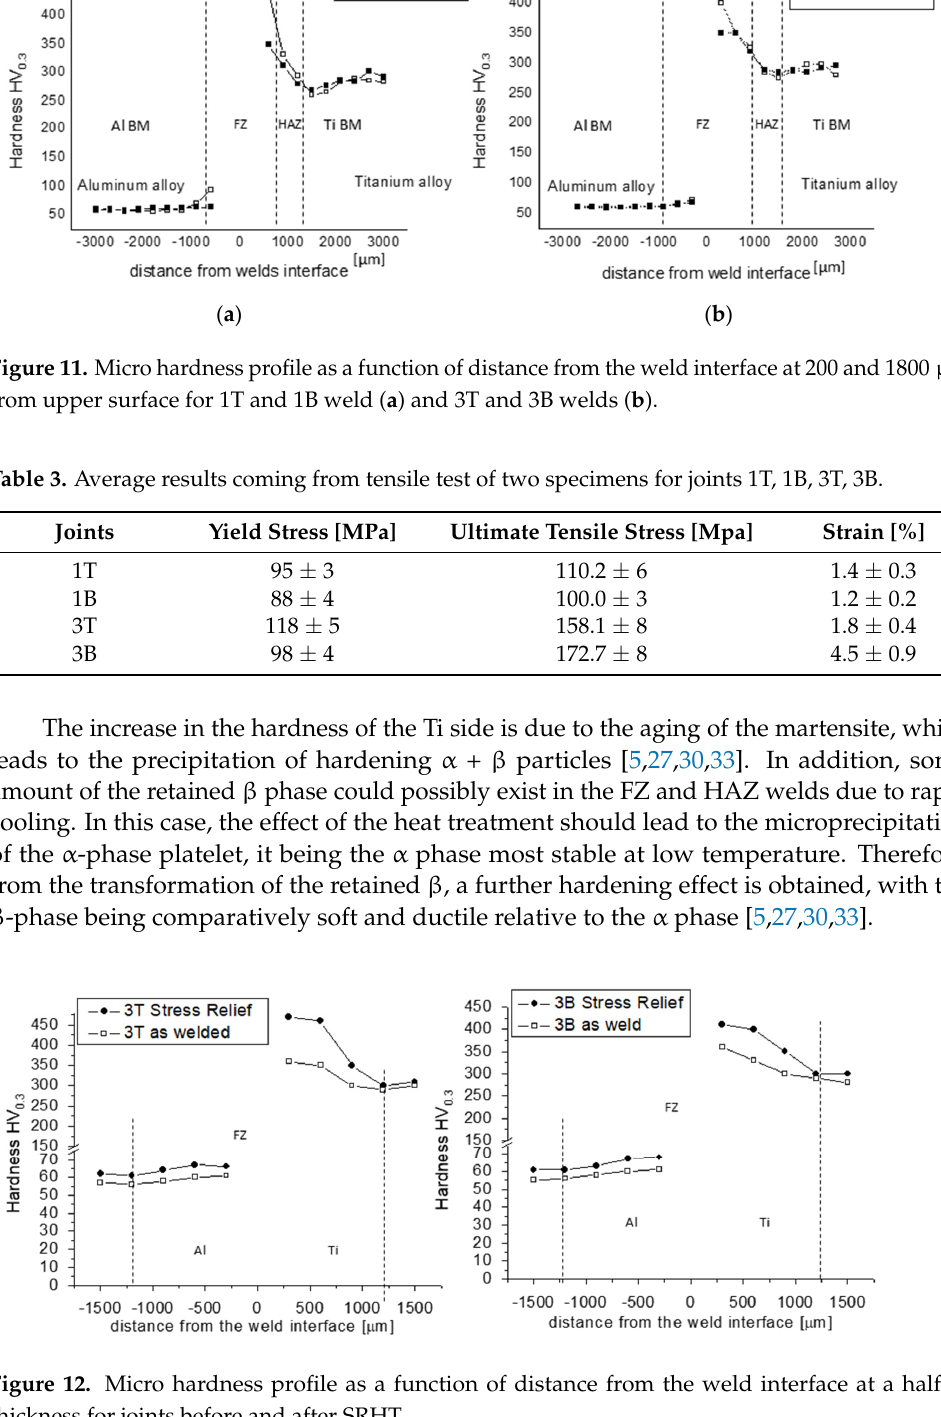
Figure 12. Micro hardness profile as a function of distance from the weld interface at a half of thickness for joints before and after SRHT.